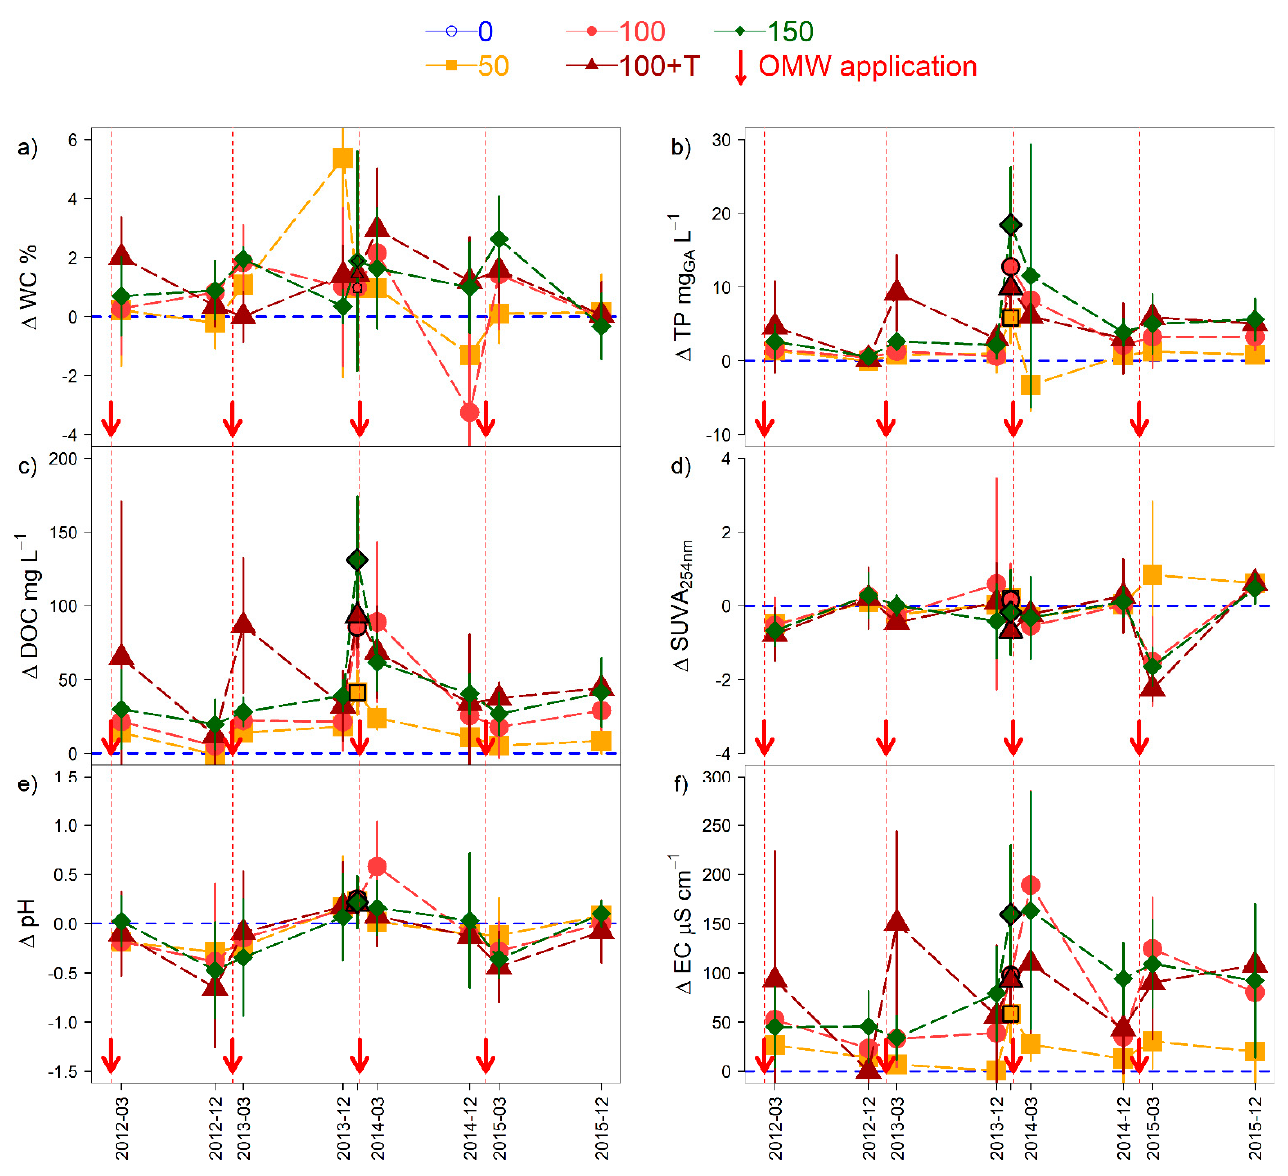
Figure 2. Evolution of physicochemical soil properties at a depth of 0–10 cm, expressed as the difference between OMW- treated and control plots. ( a ) Gravimetric water content; ( b ) total phenolic compounds (TP); ( c ) specific UV absorbance (SUVA); ( d ) pH; ( e ) electrical conductivity (EC); and ( f ) dissolved organic carbon (DOC). Bold red arrows with dashed lines mark OMW application dates. OMW application rates are 0 (control), 50, 100, and 150 m 3 ha − 1 y − 1 and 100 m 3 ha − 1 y − 1 followed by shallow tillage (100 + T).